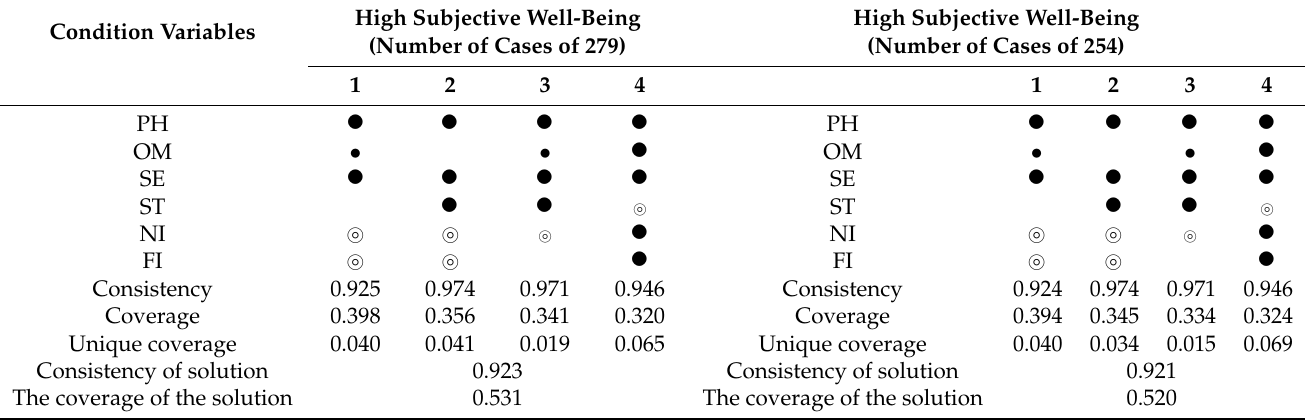
Table A3. Robustness test for number of censored